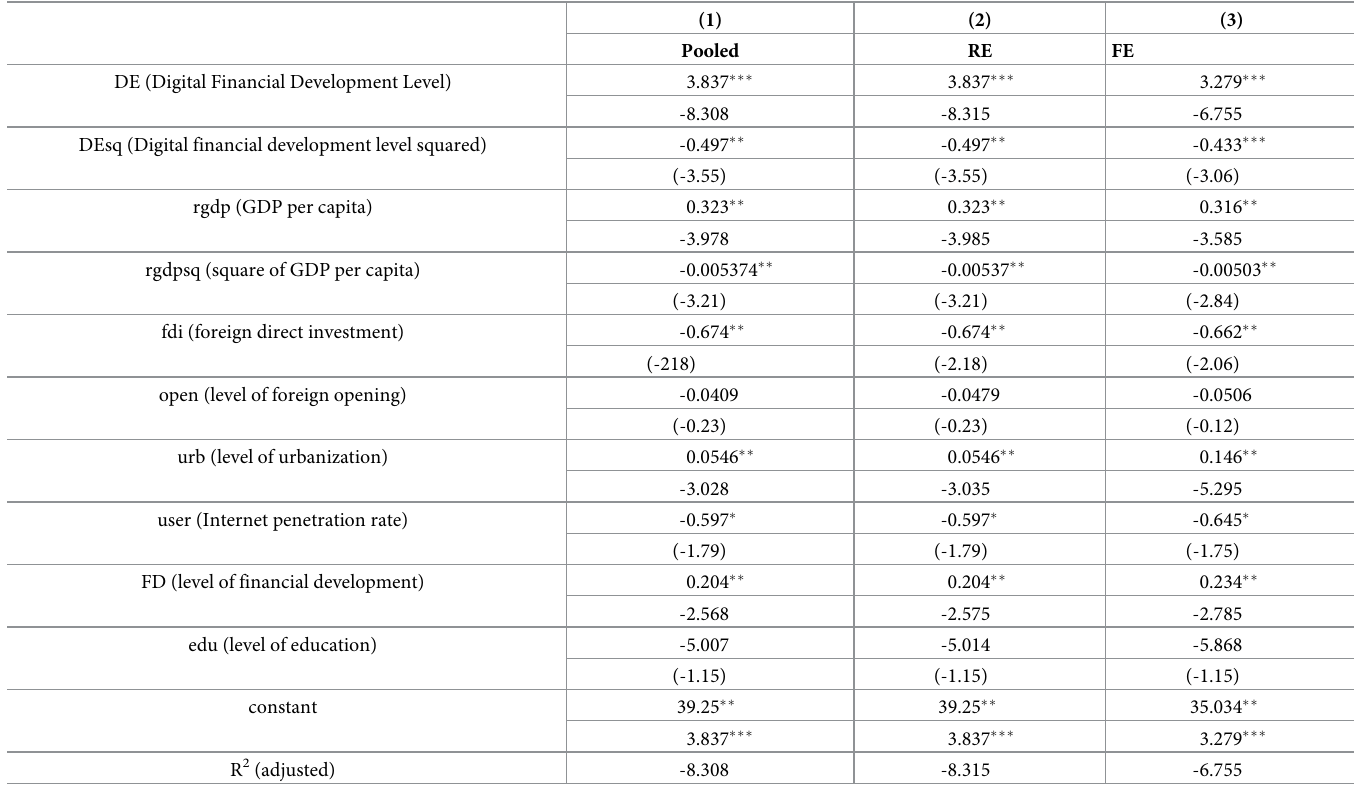
Table 3. Estimation results of the nonlinear